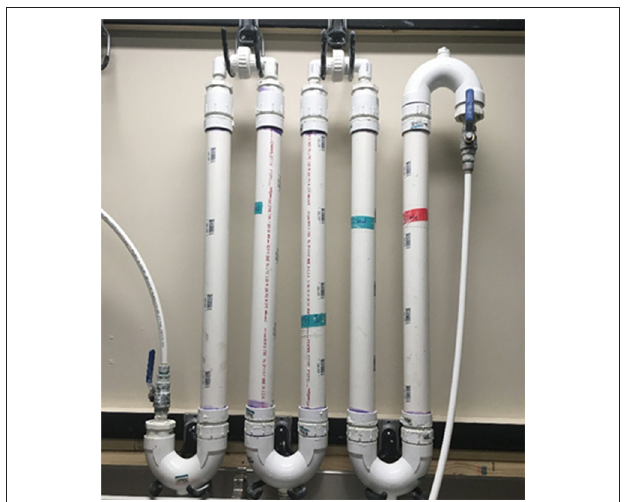
FIGURE 1 | ZVI/sand and sand filtration for laboratory and field trials of pond water. Each white PVC tube (60cm length × 5cm diameter) is filled with either (1) a mixture of 50% ZVI/50% sand (0.43–0.55 mm—particle size) for ZVI/sand filtration or (2) 100% sand (0.45–0.55mm particle size) for sand filtration. Autoclaved pond water inoculated with E. coli TVS 353 was pumped through either ZVI/sand or sand filters at 1